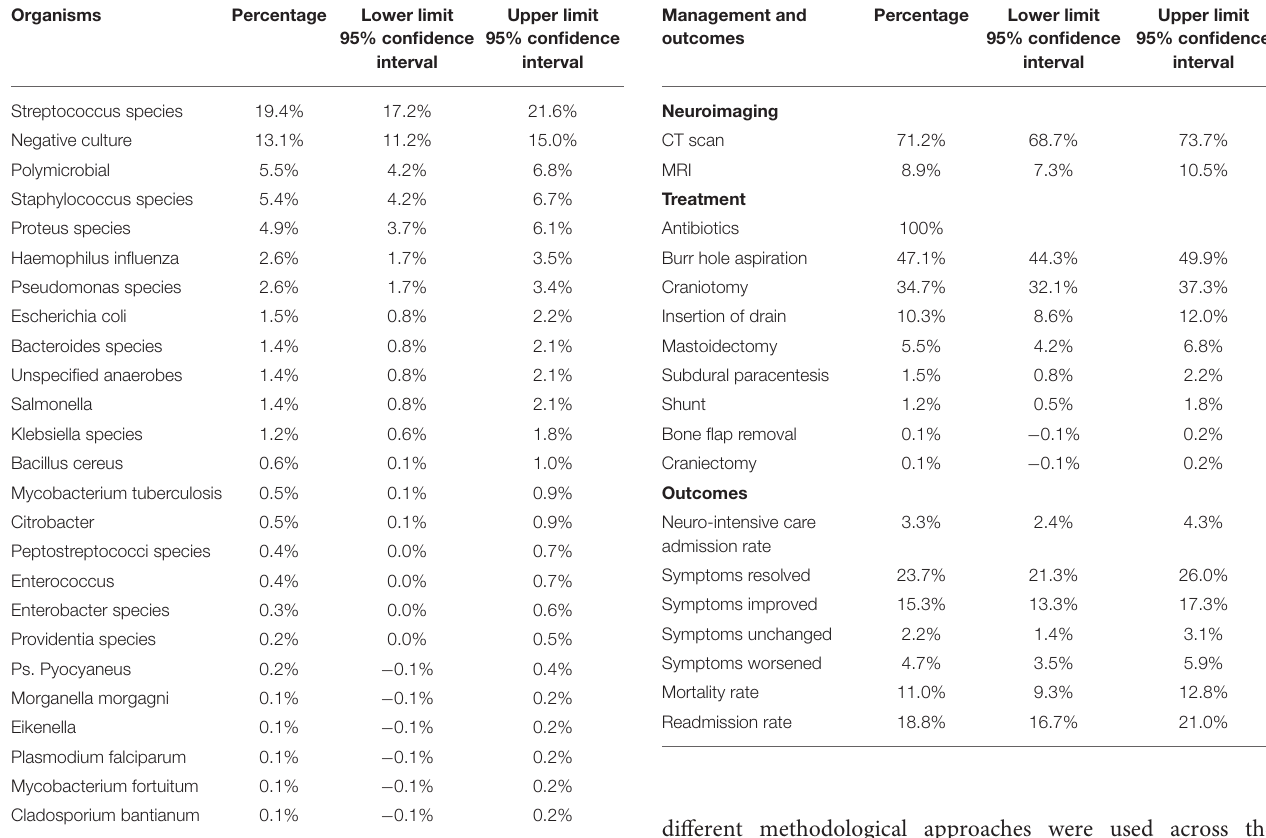
TABLE 2 | Causative organisms of intracranial suppurations. Organisms